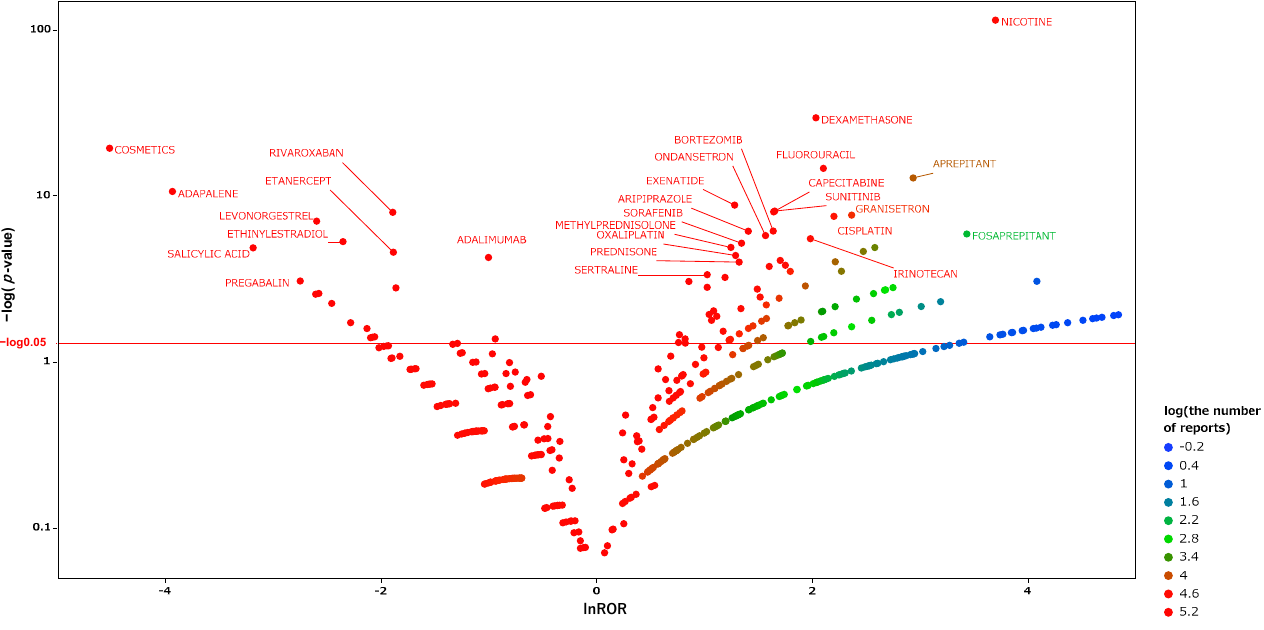
Figure 3. Medicines associated with hiccups. This figure shows the relationship between adverse effects such as hiccups and the medicines suspected to have caused them. We constructed this volcano plot by plotting the negative logarithm of the p -value ( − Log 10 p ) from Fisher’s exact test on the y -axis and the natural logarithm of the ROR (lnROR) on the x -axis. The red line shows the baseline p = 0.05. The colors of the individual points represent differences in the log of the number of reports for each drug. In this scatter plot, the signal is larger for the points (drugs) plotted in the upper right corner. The blue-to-red colors represent the number of times an adverse effect was reported.